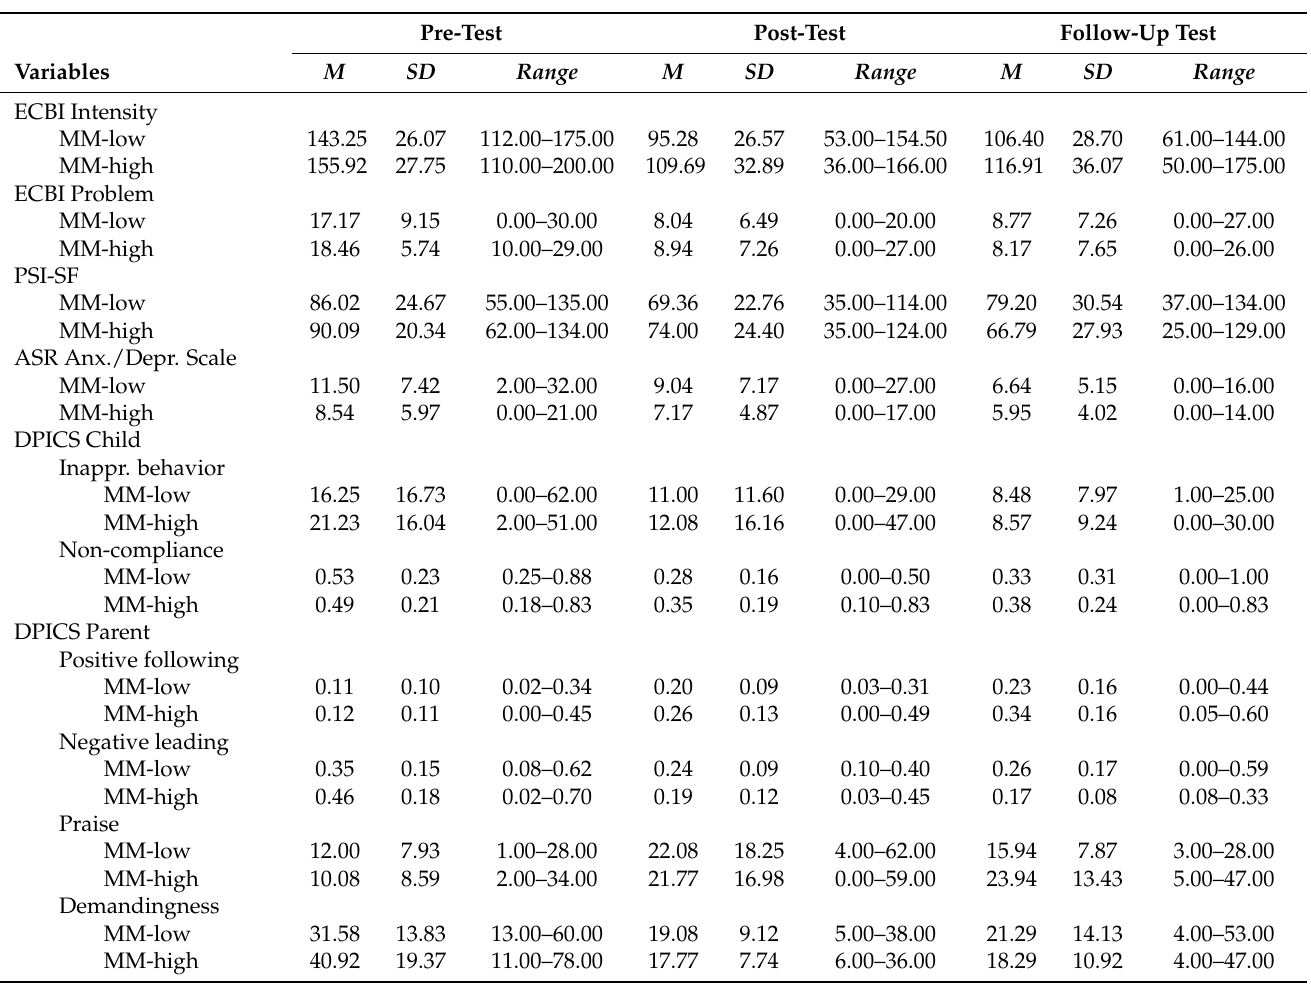
Table A2. PCIT-Clinic results for mind-mindedness: descriptives (means, standard deviations, and range).